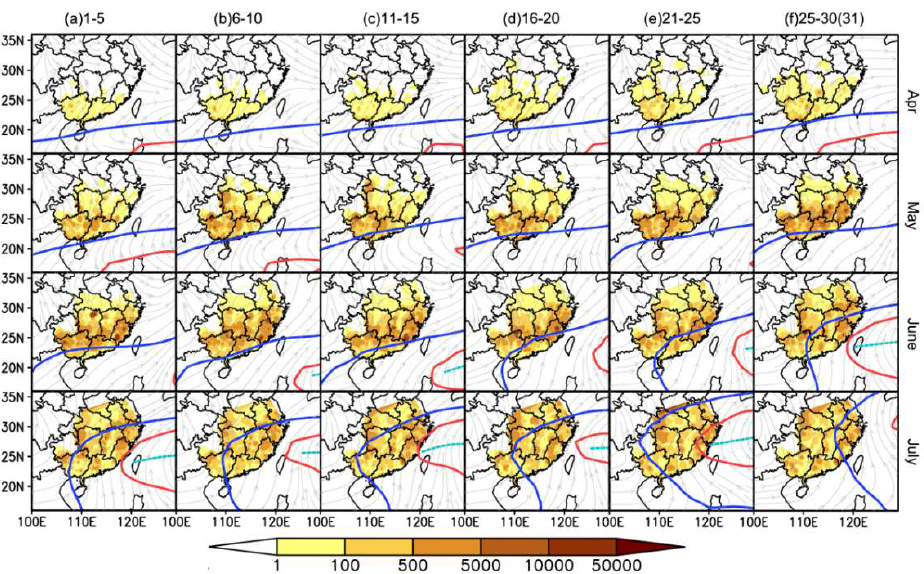
Figure 3. The spatial distribution of WBPH immigration intensity (yellow to brown areas), based on mean catches from 1977 to 2003 and the mean WPSH range for five-day periods from April to July. The raster surfaces of WBPH catches from 222 county PPS sites were interpolated using the natural neighbor method in ArcGIS. The range of the WPSH is shown using a 500 hPa geopotential height contour. The red solid lines show the contour at 5880 gpm, the blue solid lines show the contour at 5860 gpm, and the cyan dashed lines show the ridge line of the WPSH.